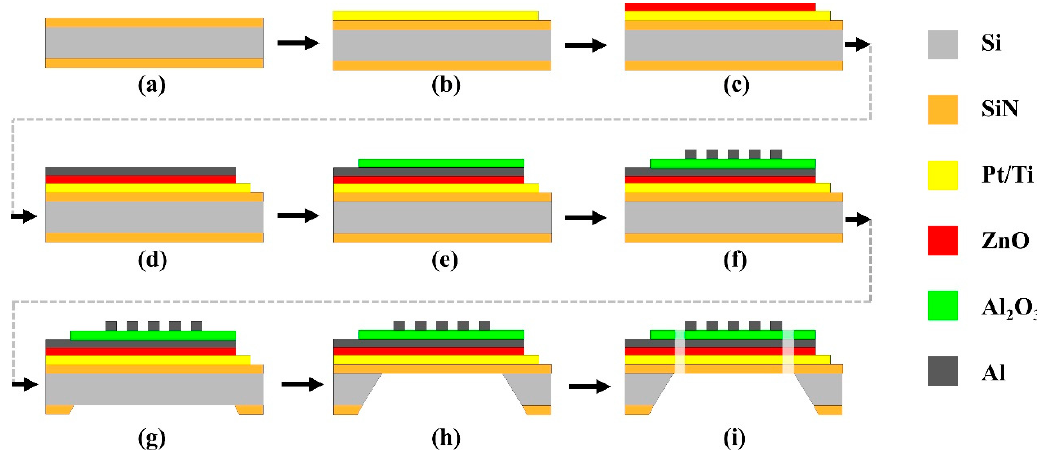
Figure 5. CMOS-compatible microfabrication process: ( a ) Rapid thermal oxidation of the silicon wafer and deposition of Si3N4 on both sides; ( b ) Deposition and lift-off of the Pt bottom electrode; ( c ) Deposition and lift-off of ZnO; ( d ) Deposition and lift-off of Al; ( e ) Deposition and lift-off of Al 2 O 3 ; ( f ) E-beam lithography of the Al disk; ( g ) Dry etching backside of Si 3 N 4 ; ( h ) Wet etching of Si by KOH; ( i ) Dry etching of Si 3 N 4 .